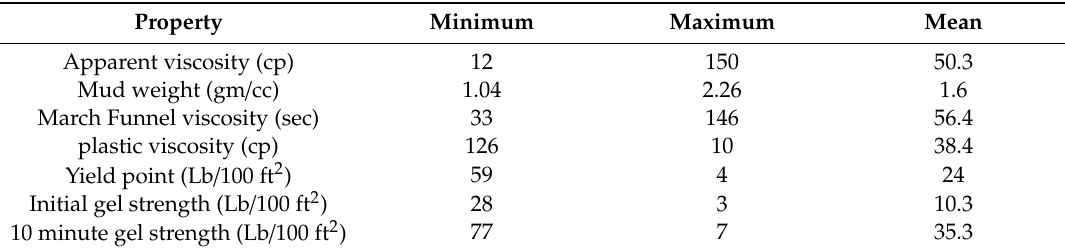
Figure 4. Log of the experimental data (input and output variables) measured in this study and used for developing the new correlation. Table 1. The range of data used for developing the new correlation and neural network model.